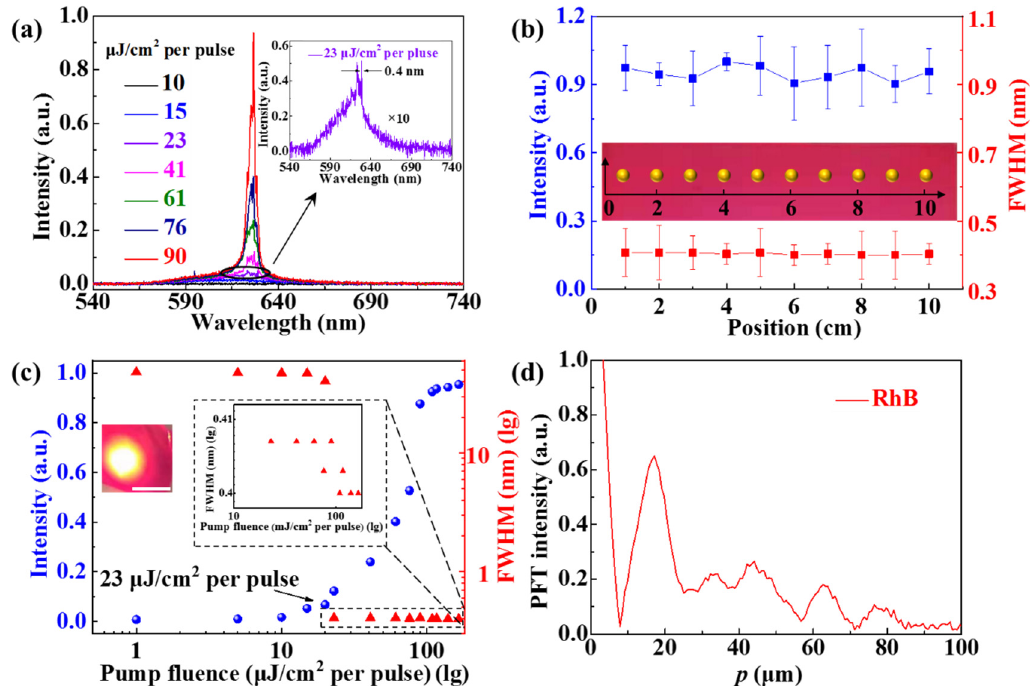
Figure 2. Spectra characterization of the coherent random laser. ( a ) The evolution of random lasing under different pumping fluences ranged from 10 to 90 μ J/cm 2 per pulse. Inset: the enlarged view of the emission spectrum with 23 μ J/cm 2 per pulse. ( b ) The FWHM (red squares) and the output intensity (blue squares) were at different pump positions. ( c ) The pump power and FWHM were at different power densities with the lasing threshold of 23 μ J/cm 2 per pulse. Scale bar is 0.3 cm. ( d ). The power Fourier transform of the random laser spectra.